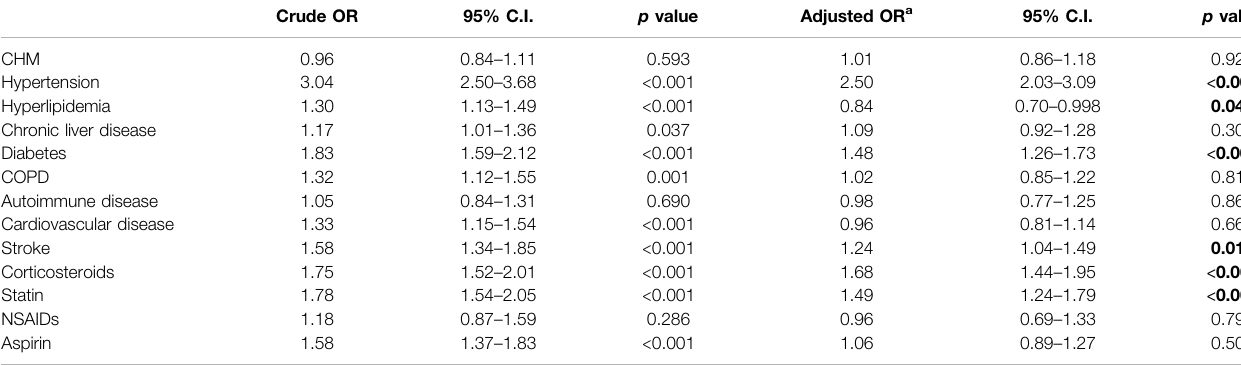
TABLE 2 | Conditional logistic regression of risk of CKD